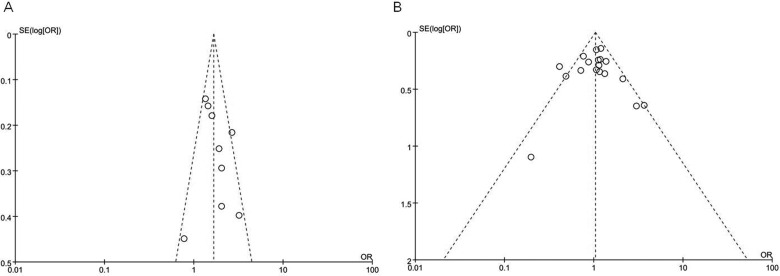
Funnel plot of IL-1α −899C/T (CT versus CC) and IL-6 −174G/C (GC versus GG) polymorphisms in cerebral infarction.